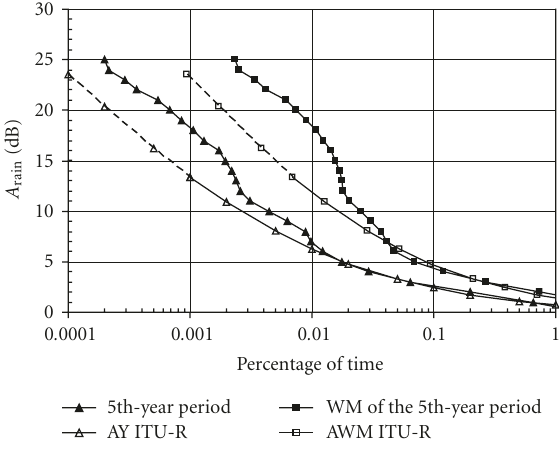
Figure 12: CDs of rain attenuation obtained for the fifth-year pe-